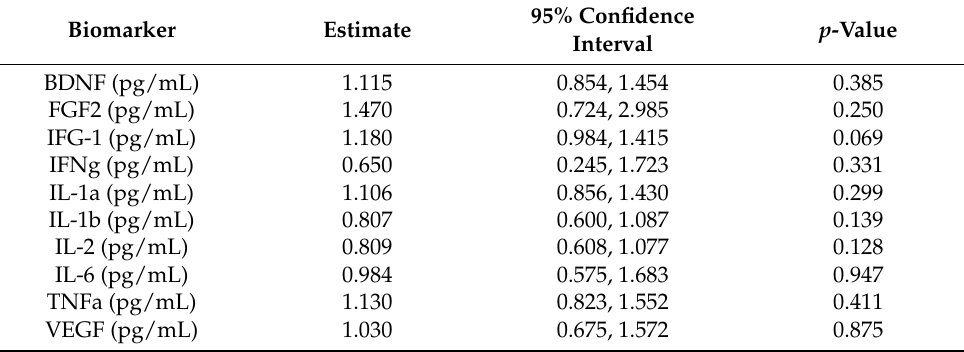
Table 9. Biomarkers—change from baseline estimates.